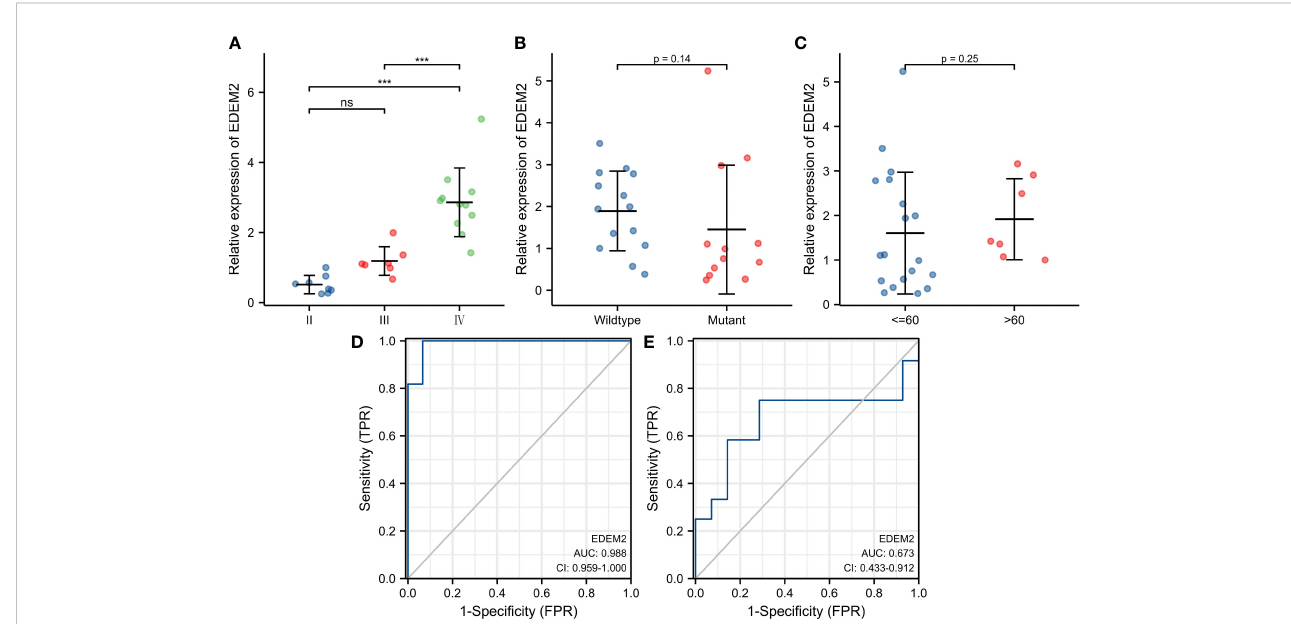
FIGURE 8 Expression pattern of EDEM2 in pathological specimens. (A-C) Pathological grade, IDH status, and age-related differences in EDEM2 expression. (D) EDEM2 prediction grade ROC curve. (E) EDEM2 ROC curve for IDH status